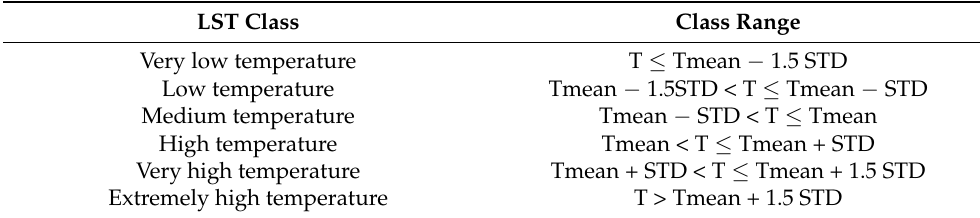
Table 3. Classification of the surface temperature